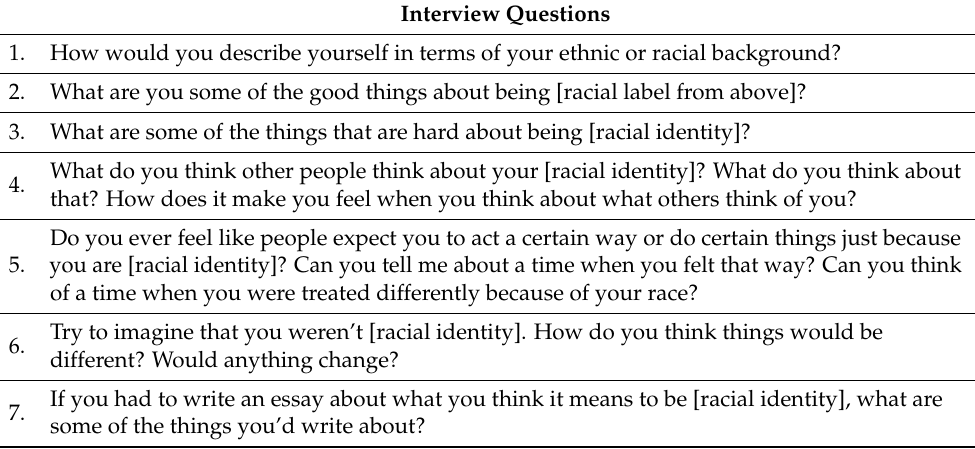
Table 2. Semi-structured interview questions on racial